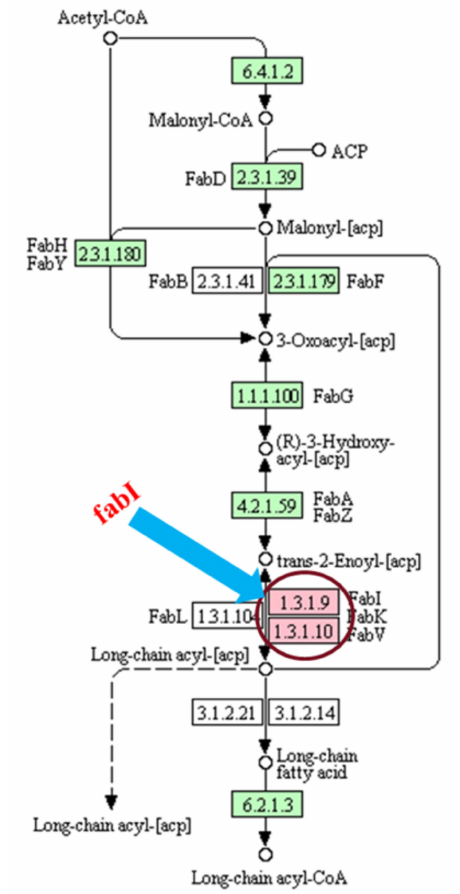
Figure 4. Selected part of type II fatty acid synthesis pathway for bacteria and the significant role of FabI in the last step of the elongation cycle in the synthesis of fatty